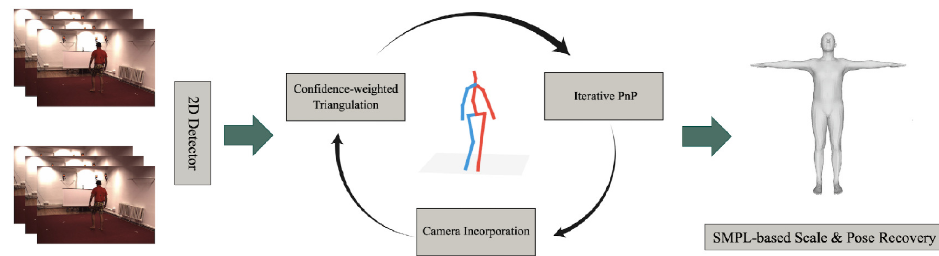
Figure 1. The schematic workflow of the proposed